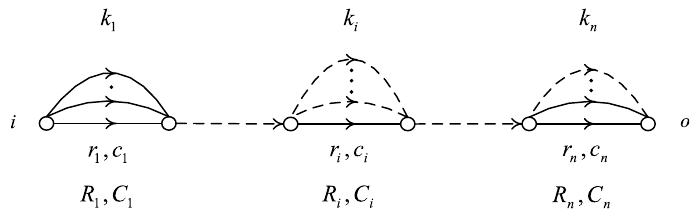
Fig. 1. Reliability model for a series-redundant system with